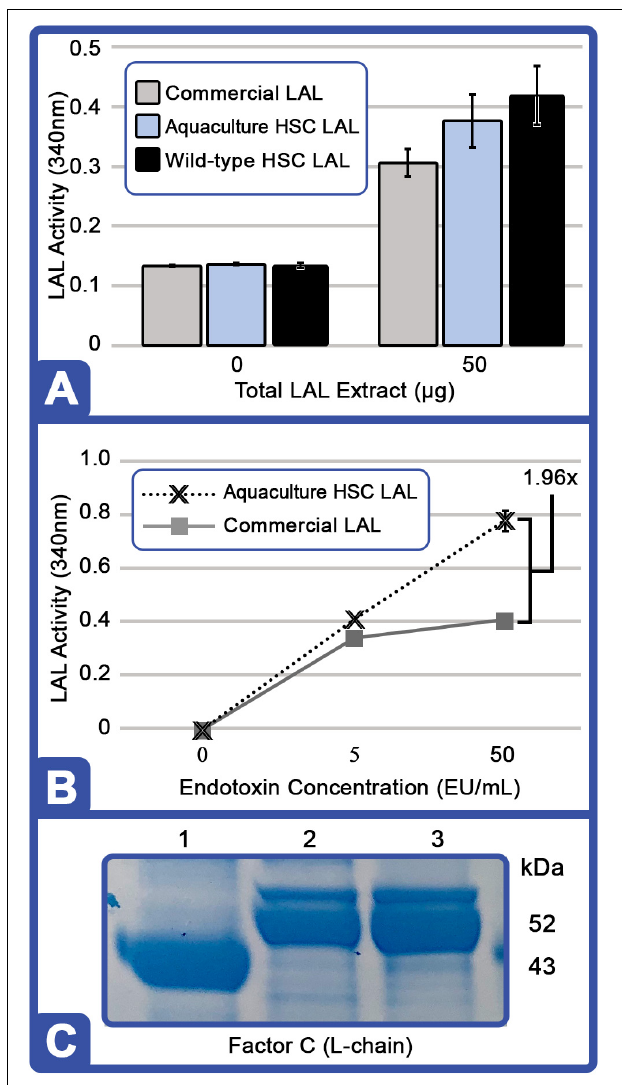
FIGURE 6 | Evaluation and protein analysis of aquaculture-derived LAL at Day 88. (A) Degree of gel clot formation (measured at 340 nm) based on the total protein content of amebocyte extracts (50 µ g) using lysates prepared from aquaculture HSC (equal amounts of protein pooled from individual HSC in Cohort B; n = 6); freshly removed from wild-captured HSC (wild-type); or a commercial kit (Sigma E-Toxate TM ). The total LPS concentration used for each was 50 EU/ml. (B) Degree of clot formation (measured at 340 nm) of aquaculture LAL (150 µ g total protein, equal amounts of protein pooled from individual HSC in Cohort B; n = 6) compared to a commercial kit (150 µ g protein) at different endotoxin concentrations: 0, 5.0, and 50.0 EU/ml. (C) Coomassie blue staining of crude protein lysate (10 µ g per well): commercial LAL (Lane 1), aquaculture LAL (Lane 2), and wild-type LAL (Lane 3). Aquaculture LAL is representative of equal amounts of protein pooled from individual HSC in Cohort B ( n = 6). Molecular weight marker (SeeBlue TM Plus2; Invitrogen, Thermo Fisher Scientific) is